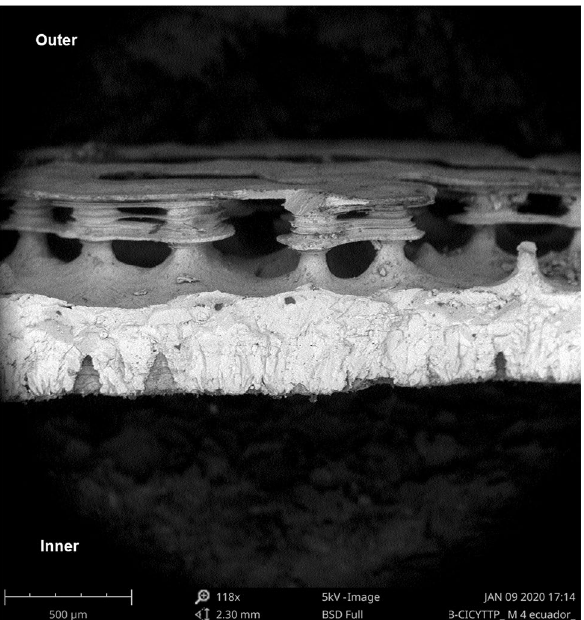
Figure 2. Radial view of an eggshell under SEM (Scanning Electron Microscope). This picture shows the external ornamentation form by columns and bridges between them and the main eggshell beneath with cone shaped pores. Note the absence of pore apertures in the external face.